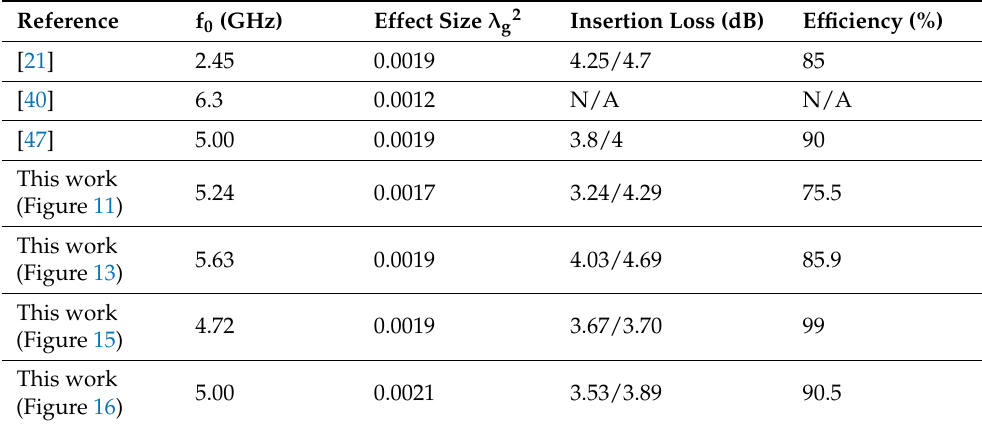
Table 3. Comparison between different models of power